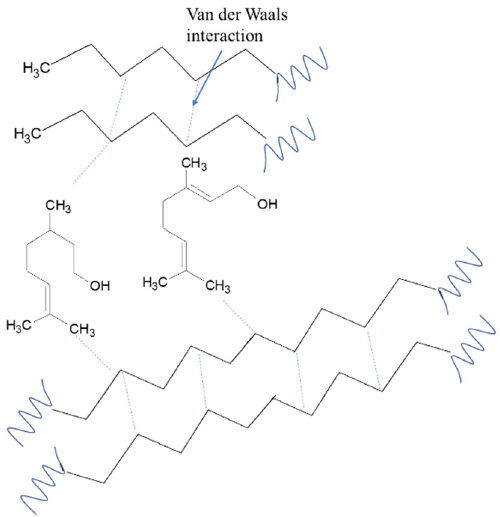
Figure 6. Hypothesis of diesel fuel interaction with FB (citronellol and geraniol as main components) [9].